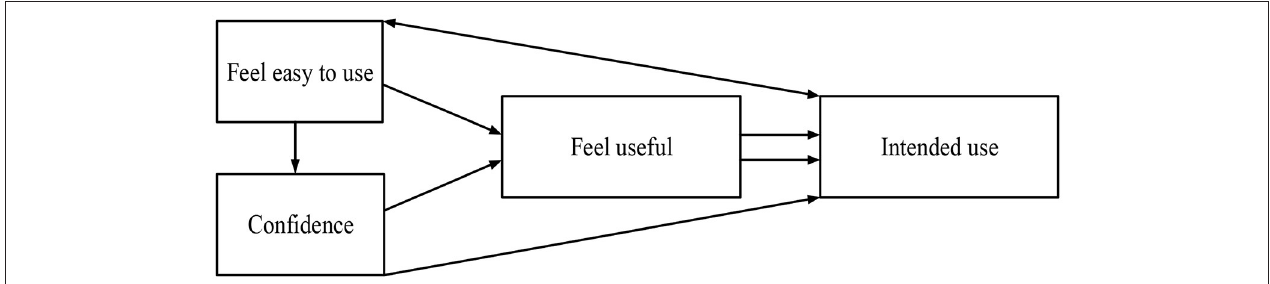
FIGURE 1 | Technology acceptance model (TAM)